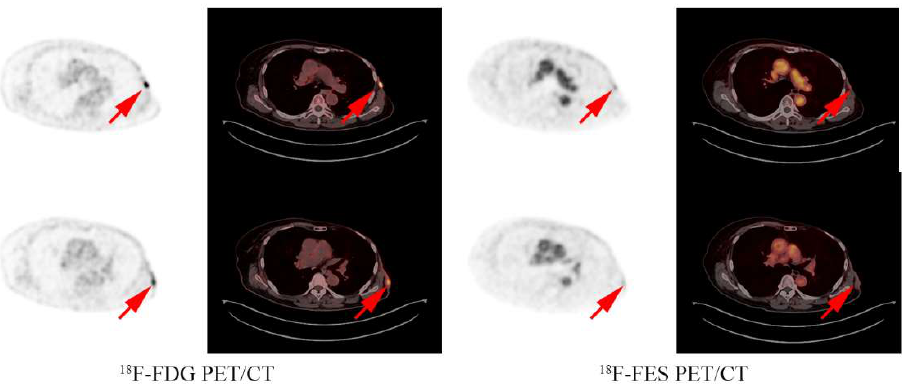
Figure 3. Analysis examples: A 73 year old female had an FES positive lesion in the chest wall and a FES negative lesion in the axillary lymph nodes and received fulvestrant treatment with a PFS of 4 months.